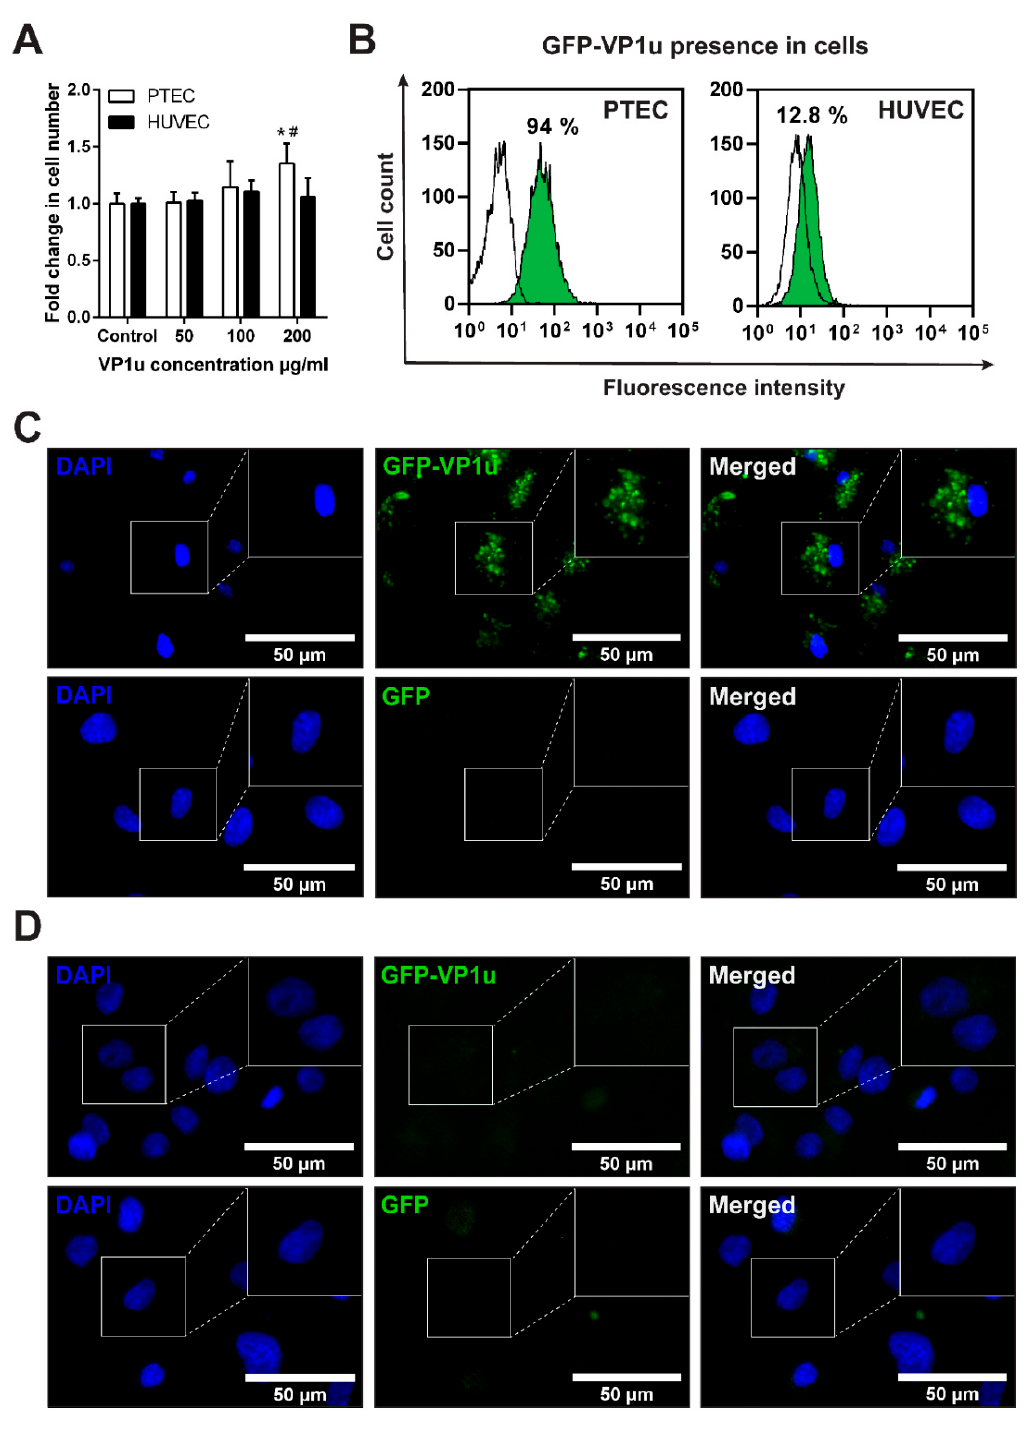
Figure 3. EC viability assay and GFP-VP1u internalization. ( A ) Viability of EC exposed to 50, 100 and 200 µg/mL of VP1u. The data is shown as a ratio of the 24 h control. The data are shown as mean ± SD. p ≤ 0.05 (*) compared to the 24 h control; p ≤ 0.05 (#) compared to 50 µg/mL concentration. ( B ) Flow cytometry analysis of the GFP-VP1u’s ability to enter the cells. ( C ) GFP-VP1u internalization in PTEC. ( D ) GFP-VP1u internalization in HUVEC.